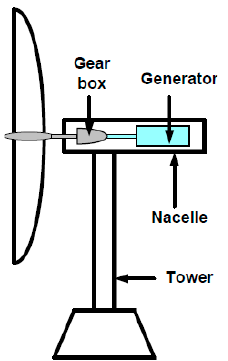
Figure 2. A horizontal-axis wind turbine. Table 2. Features of HAWTs and VAWTs [25–27].